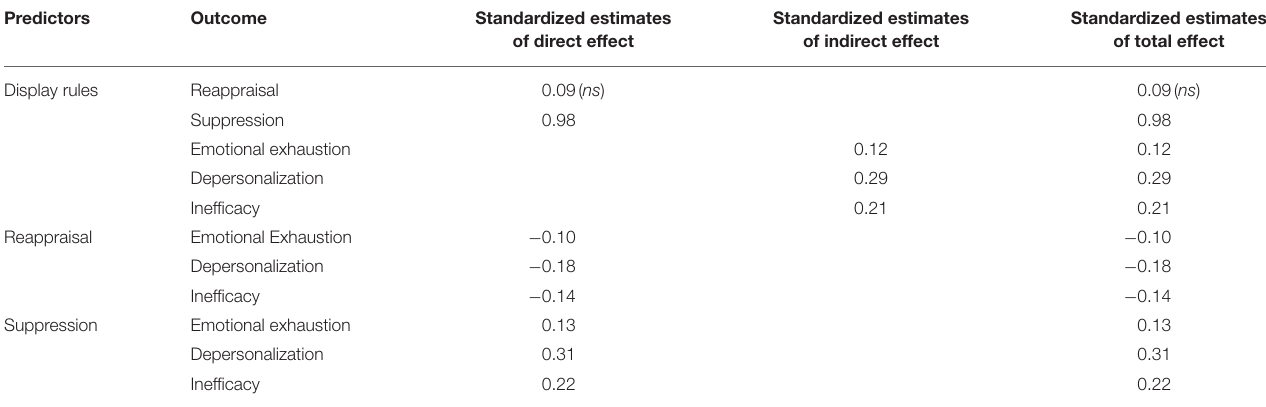
TABLE 3 | Standardized direct effects, indirect effects, and total effects in the